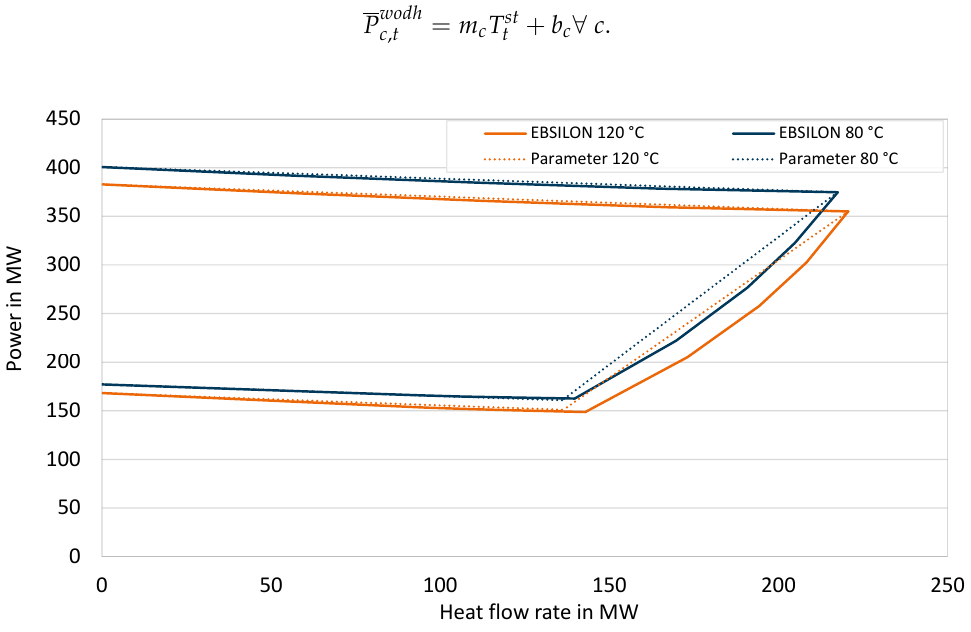
Figure 3. P – ˙ Q -diagram of an extraction steam